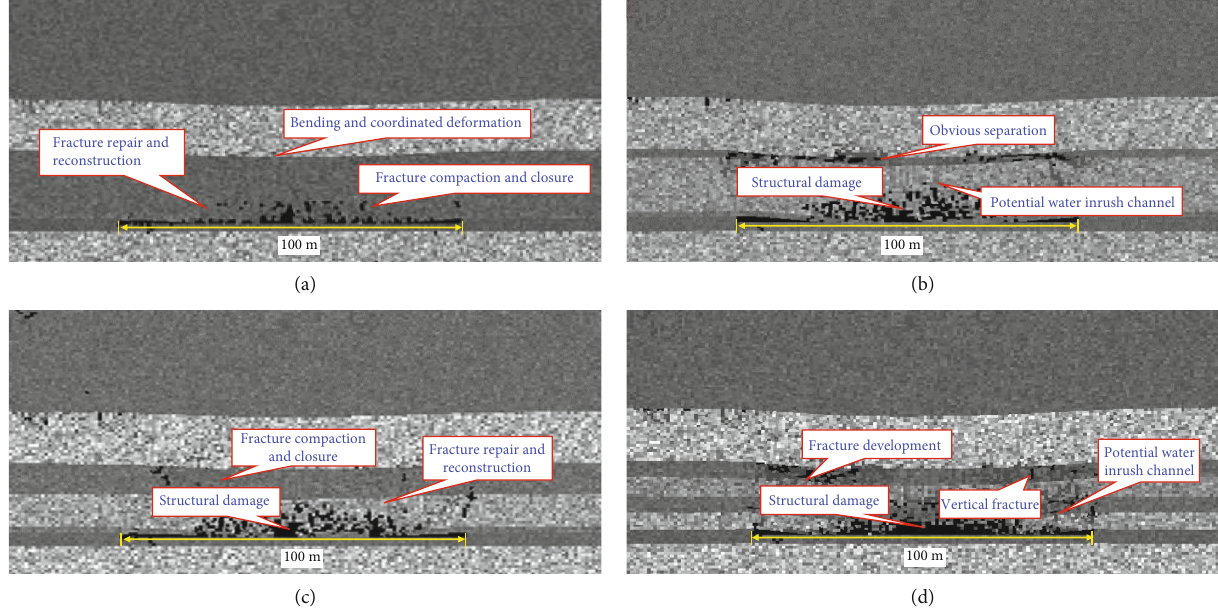
Figure 3: Fracture evolution and seepage response of di ff erent overlying strata structures: (a) single-layer soft KAS; (b) single-layer hard KAS; (c) double-layer composite KAS; (d) four-layer composite KAS.